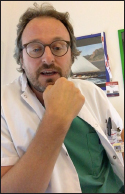
Prof. Marco Midulla